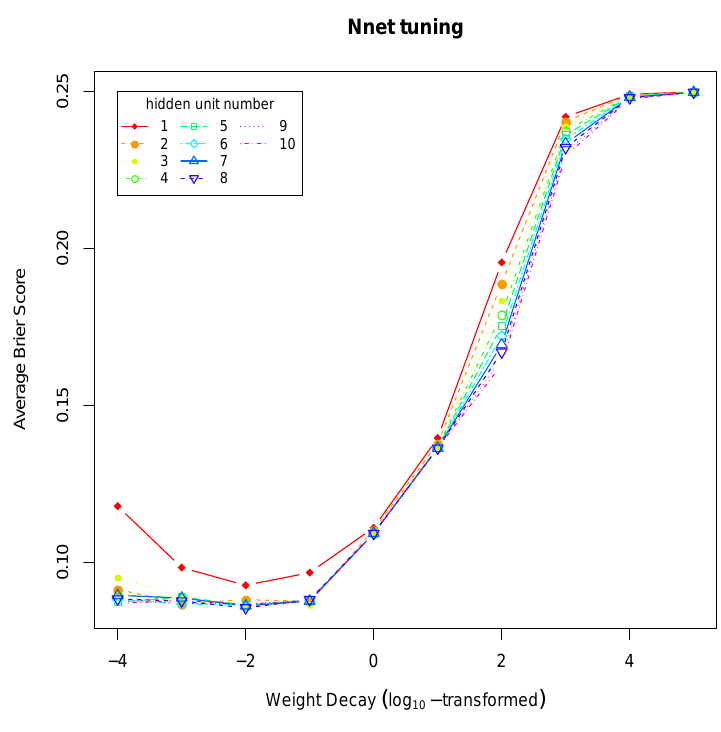
Figure 6. The performance profile of the neural network for predicting the statement mutation